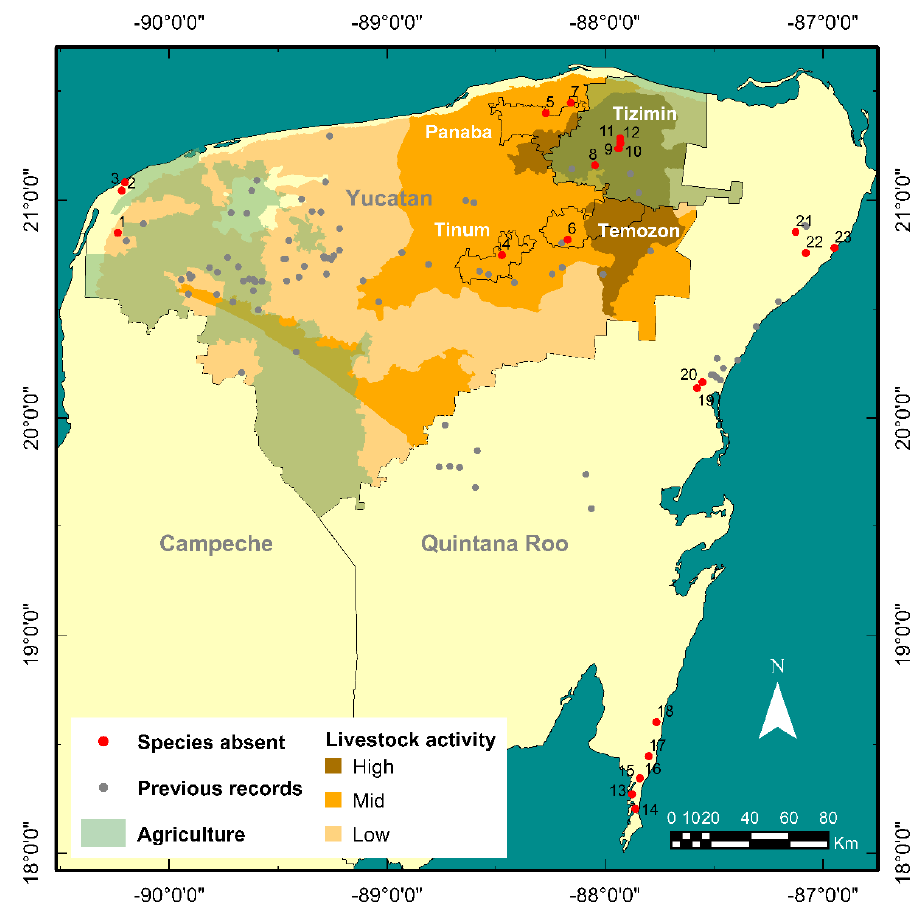
Figure 7. Regions with agricultural activity (green zones) and livestock activity intensity (brown zones) within the state of Yucatán [40,89,90]. Four municipalities in the state of Yucatan (outlined in black with white labels). Locations where A. cenotensis was not sighted (red dots) are numbered as follows according to state (bold italics) and municipality (in parenthesis): Yucatan : (1) Sabtún (Celestún); (2) Cauich (El Palmar); (3) Polac (El Palmar); (4) K’ax Ek (Tinum); (5) Rancho Sacbé (Panabá); (6) Hubikú (Temozón); (7) San Juan del Río (Panabá); (8) Saa’kal (Tizimín); (9) X’bohom (Tizimín); (10) Dzonot Aké (Tizimín); (11) unnamed cenote under papaya plantation (Tizimín); (12) Tzitzilá (Tizimín). Quintana Roo : (13) Pandora (Othón P. Blanco); (14) Bajo de Judas (Othón P. Blanco); (15) water spring (Othón P. Blanco); (16) water spring (Othón P. Blanco); (17) mangrove cenote (Othón P. Blanco); (18) Dagobah (Othón P. Blanco); (19) Angelita (Tulum); (20) Ka’an Lu’um (Tulum); (21) Zapote (also known as Hell’s Bells, Benito Juárez); (22) Cocom (Solidaridad); (23) Crustacea (Solidaridad).